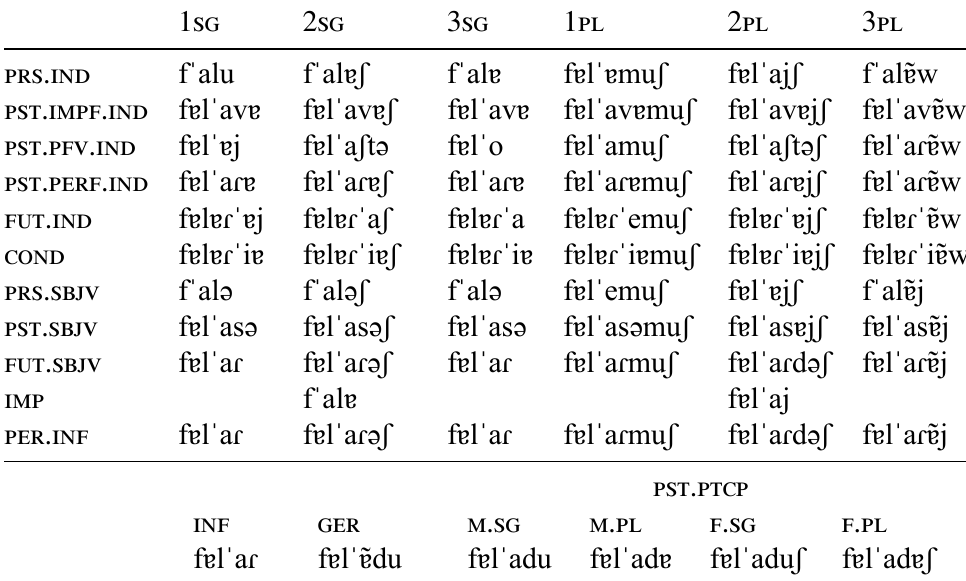
Table 2: The verbal paradigm of FALAR